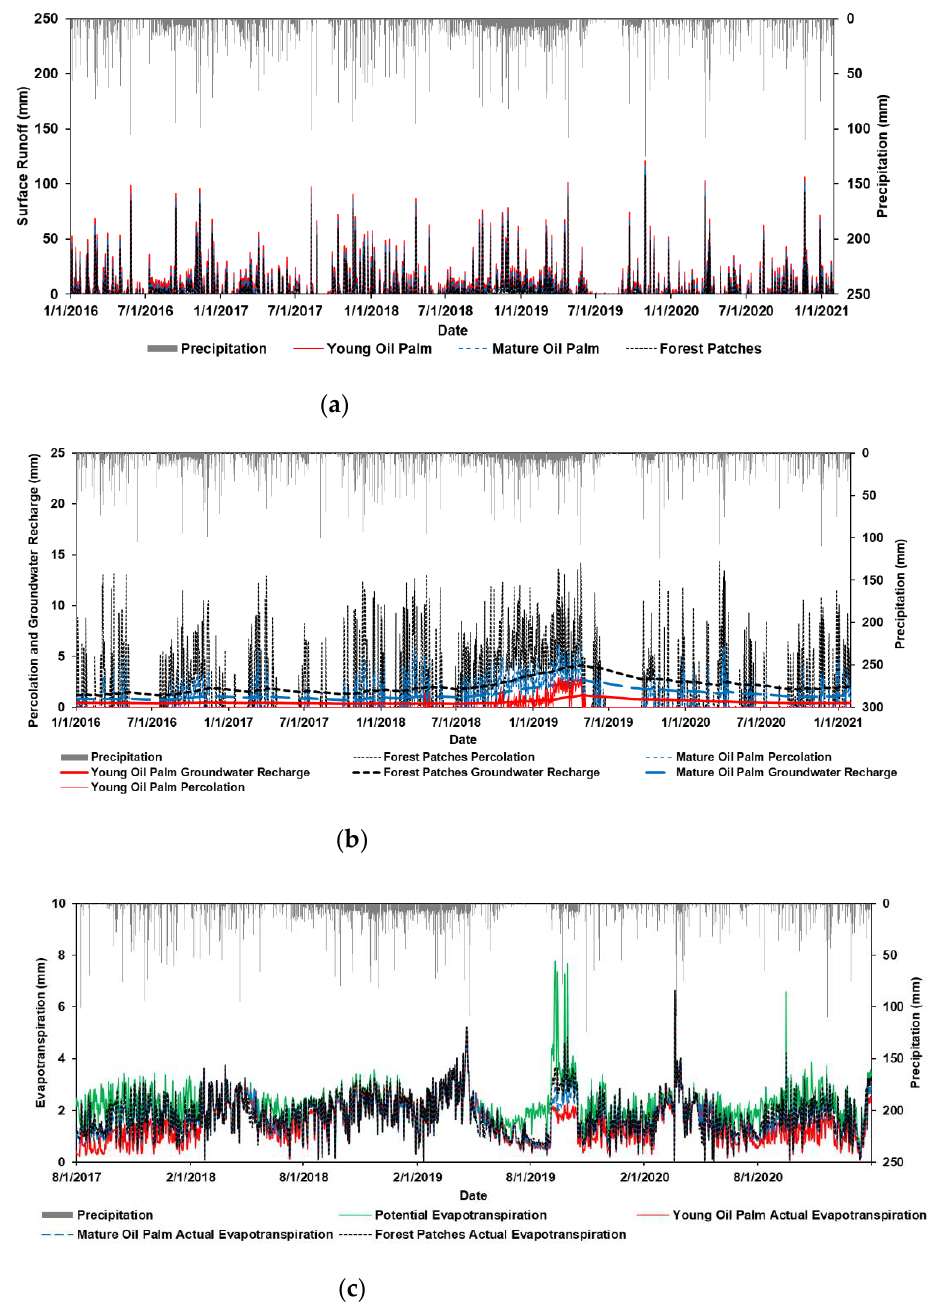
Figure 4. Hydrograph of water regulation ecosystem service elements: surface runoff ( a ), groundwater recharge ( b ), actual evapotranspiration ( c ).